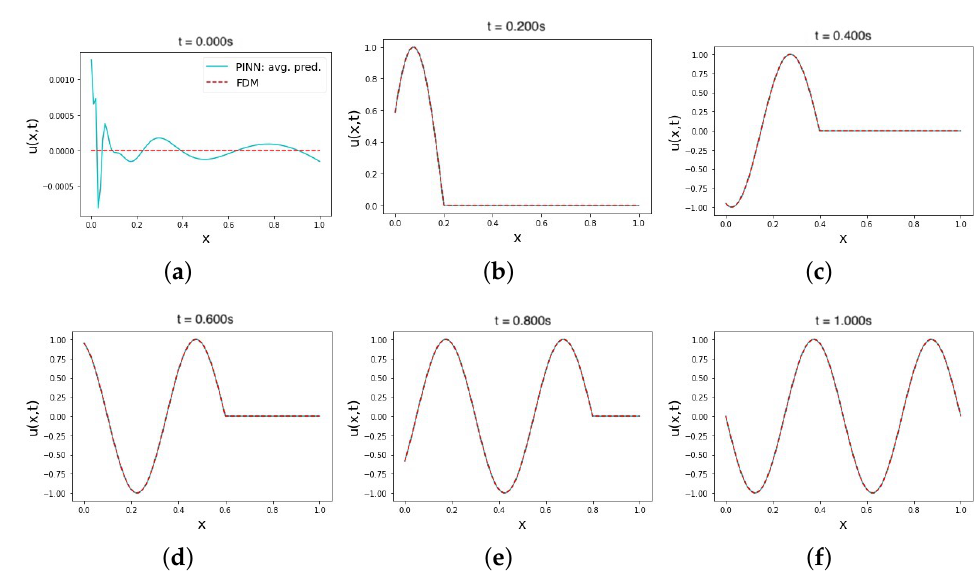
Figure 3. The average solution prediction of the wave equation using a PINN with soft IC and BC constraints (soft–soft). Plots ( a – f ) show the average prediction values of 10 trials of multiple time instances in the range [0, 1]. All training points are sampled uniformly from the domain in all